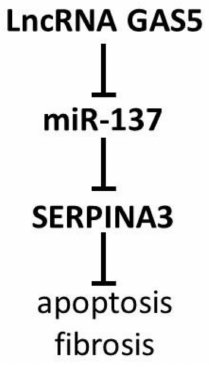
Figure 3. A decrease in SERPINA3 mRNA expression as a result of the inhibition of miR-137 by LncRNA GAS5 may cause lower apoptosis and/or